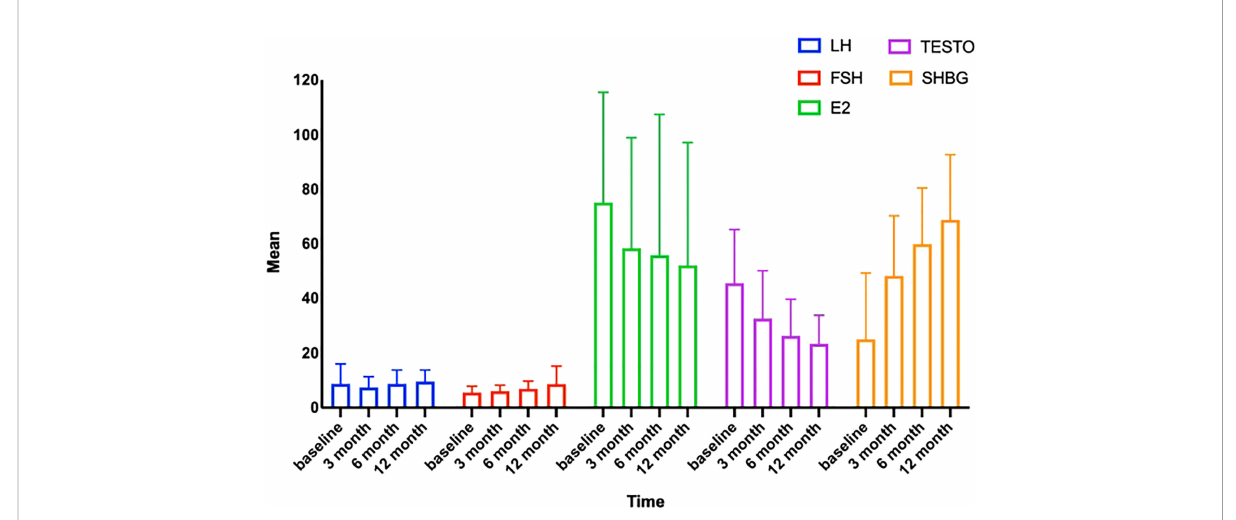
FIGURE 2 Trends in sex hormones with time. LH, luteinizing hormone; FSH, follicle-stimulating hormone; TESTO, testosterone; SHBG, sex hormone- binding globulin; E2,